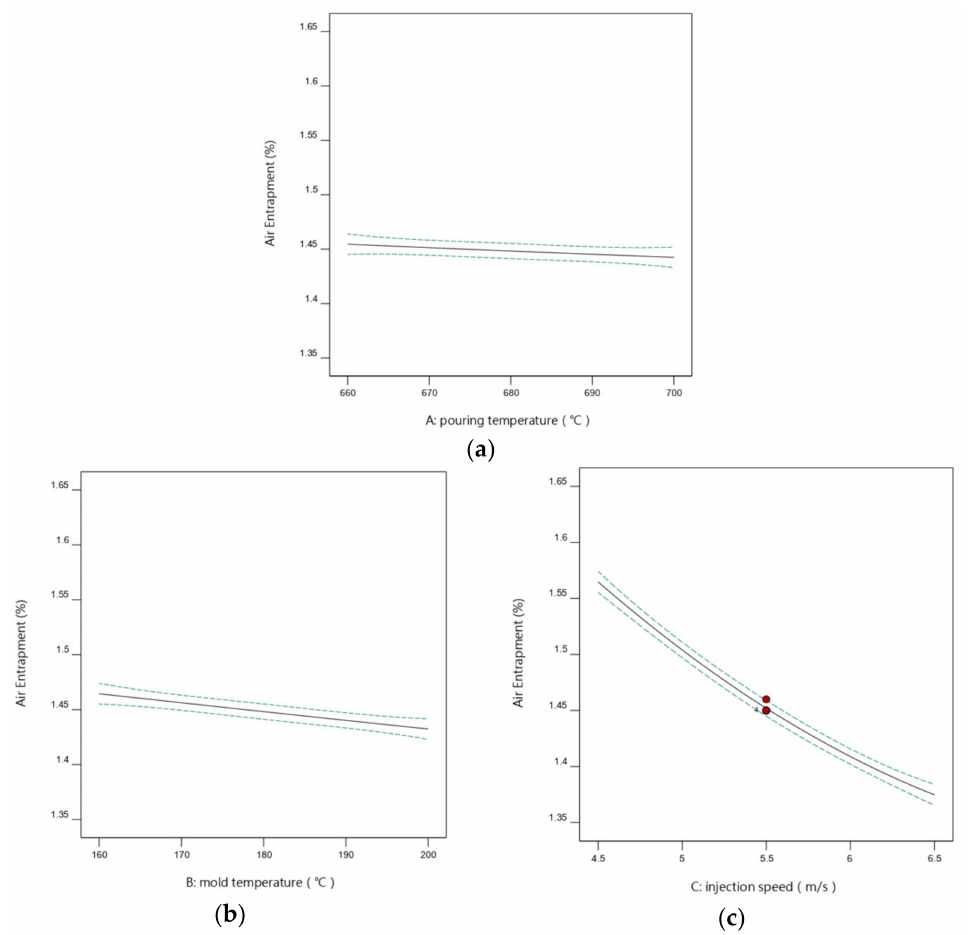
Figure 4. Effect of single factors on air entrapment rate (Y 1